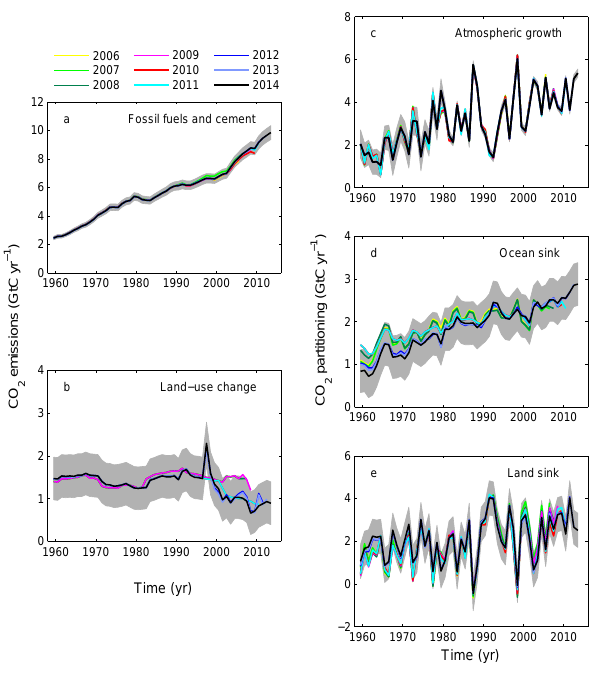
Figure 9. Comparison of global carbon budget components re- leased annually by GCP since 2006. CO 2 emissions from both (a) fossil fuel combustion and cement production ( E FF ), and (b) land-use change ( E LUC ), and their partitioning among (c) the atmosphere ( G ATM ), (d) ocean ( S OCEAN ), and (e) land ( S LAND ). See legend for the corresponding years, with the 2006 carbon bud- get from Raupach et al. (2007), 2007 from Canadell et al. (2007), 2008 released online only, 2009 from Le Quéré et al. (2009), 2010 from Friedlingstein et al. (2010), 2011 from Peters et al. (2012b), 2012 from Le Quéré et al. (2013), and 2013 from Le Quéré et al. (2014) and this year’s budget (2014). The budget year gener- ally corresponds to the year when the budget was first released. All values are in GtCyr − 1